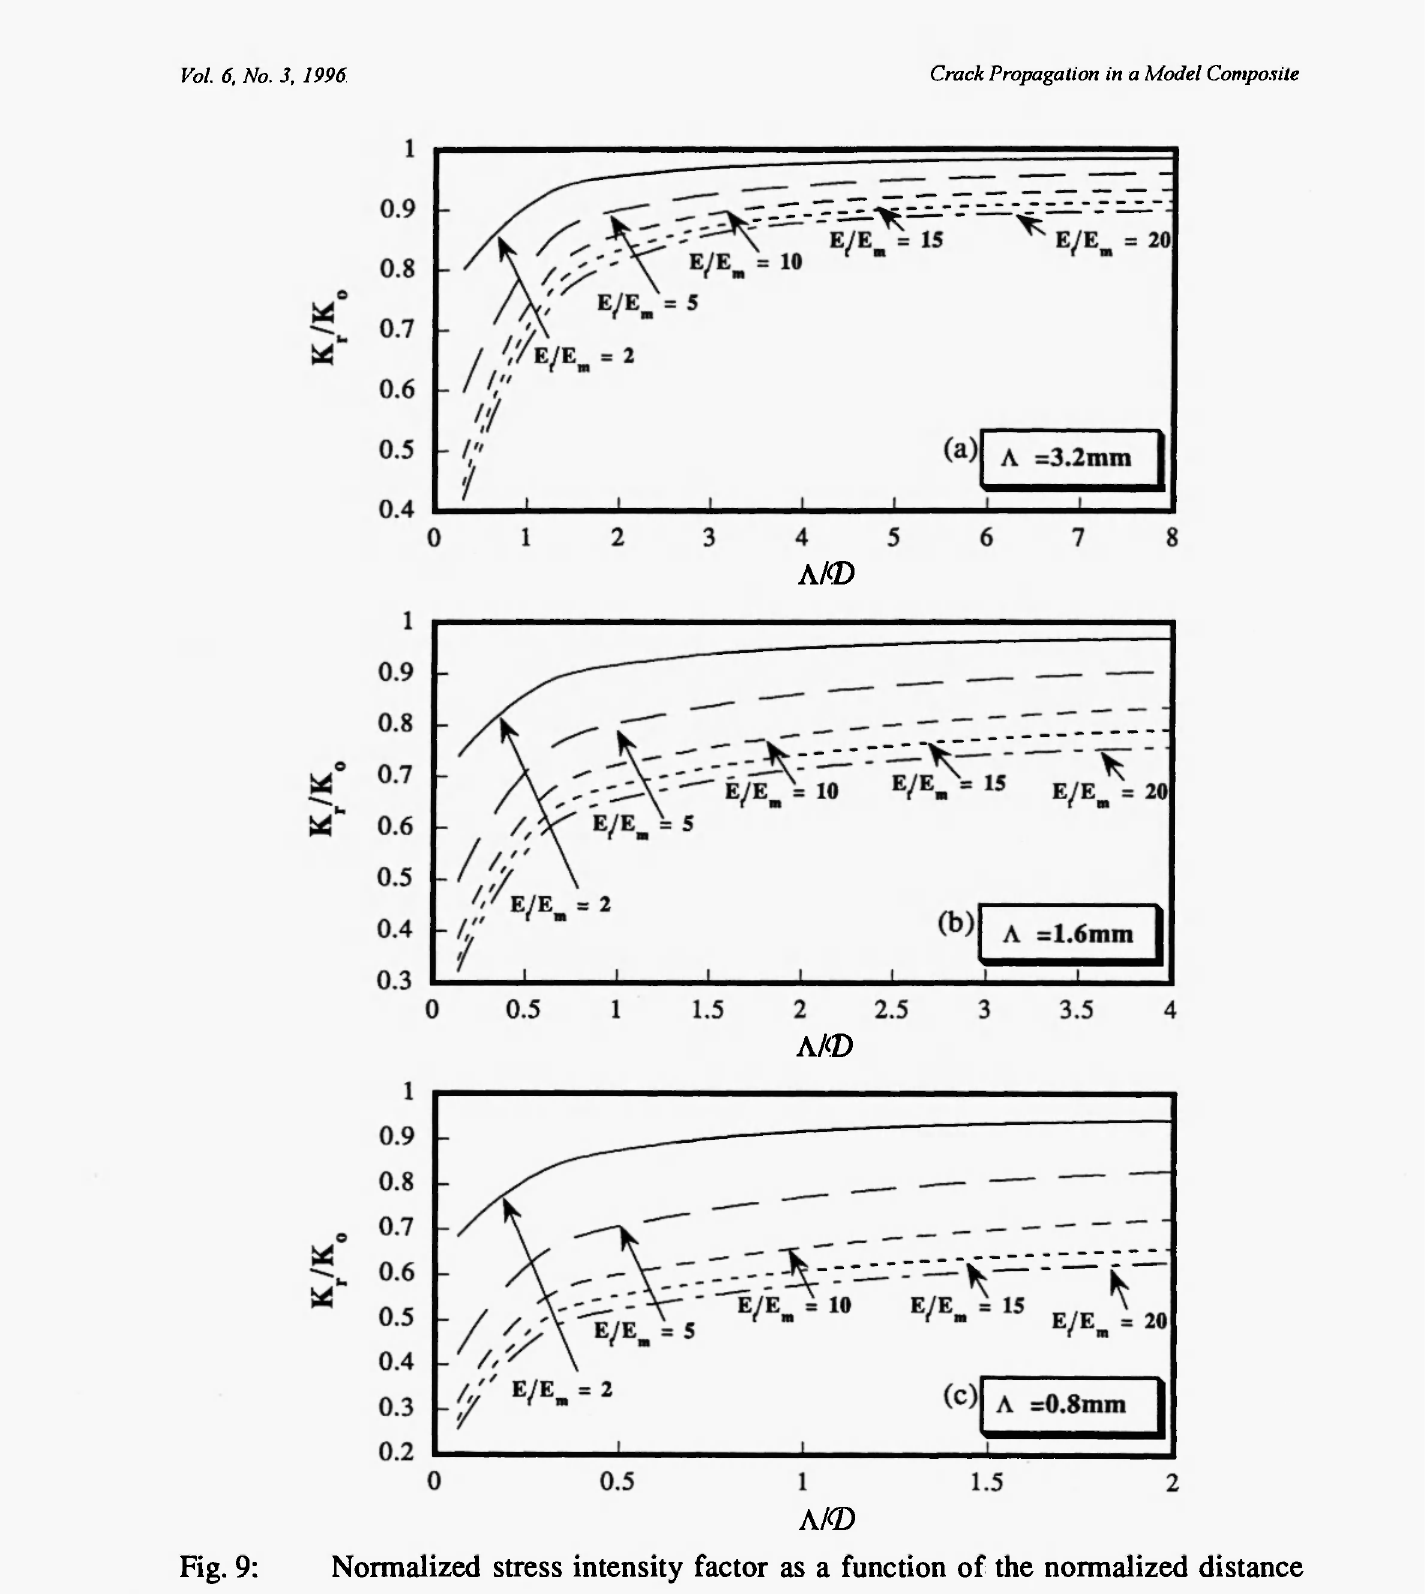
Fig. 9: Normalized stress intensity factor as a function of the normalized distance from the crack tip for various elastic